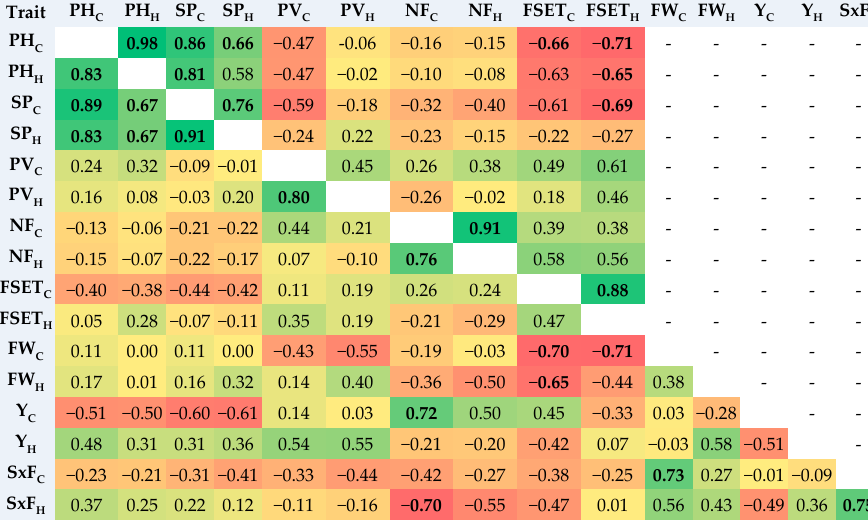
Figure 2. Pearson’s correlation coefficients among measured traits (plant height, PH; stigma position, SP; pollen viability, PV; number of flowers per inflorescence, NF; fruit set, FSET; fruit weight, FW; yield, Y; number of seeds per fruit, SxF) in 2007 (upper triangle) and in 2019 (bottom triangle). Subscripts “C” and “H” indicate values detected in the control and heat field, respectively. Coefficients are reported in cells with green to red color, ranging from high positive to high negative correlations; coefficients statistically significant for p ≤ 0.05 are written in bold. In 2019, all traits showed significant positive correlations between means recorded under the control and heat conditions, with the exceptions of FSET, FW, and Y (Figure 2, lower triangle). Both PH measures were correlated with SP values. NF in the control field was positively correlated with Y in the control and negatively with SxF in the heat field. ured. Finally, under control conditions, bigger fruits also had more seeds (Figure 2).